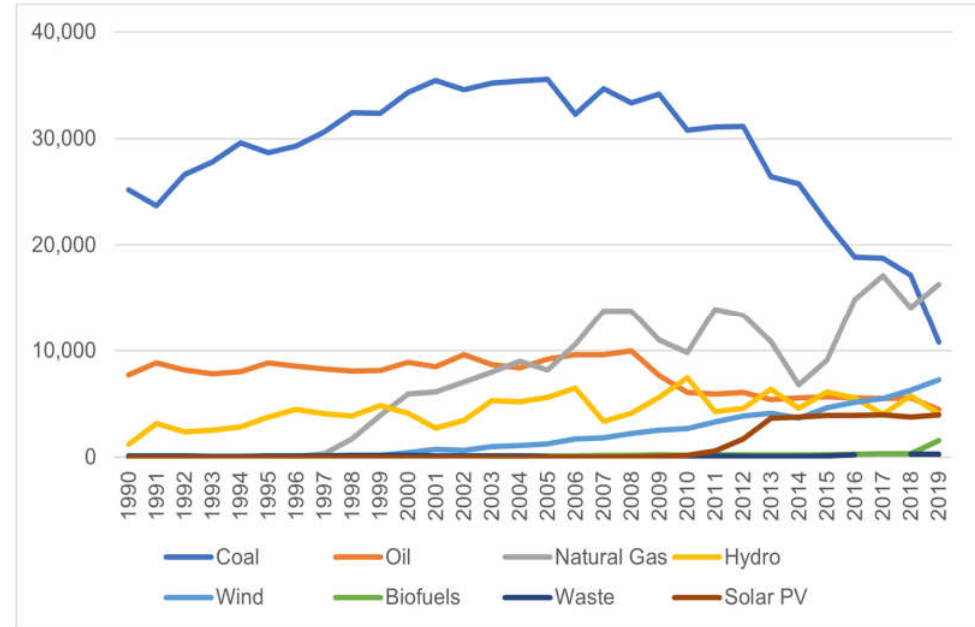
Figure 1. Electricity generation by Source in Greece 1990–2019. Source of data: International Energy Agency (https://www.iea.org/ accessed on 10 September 2020).